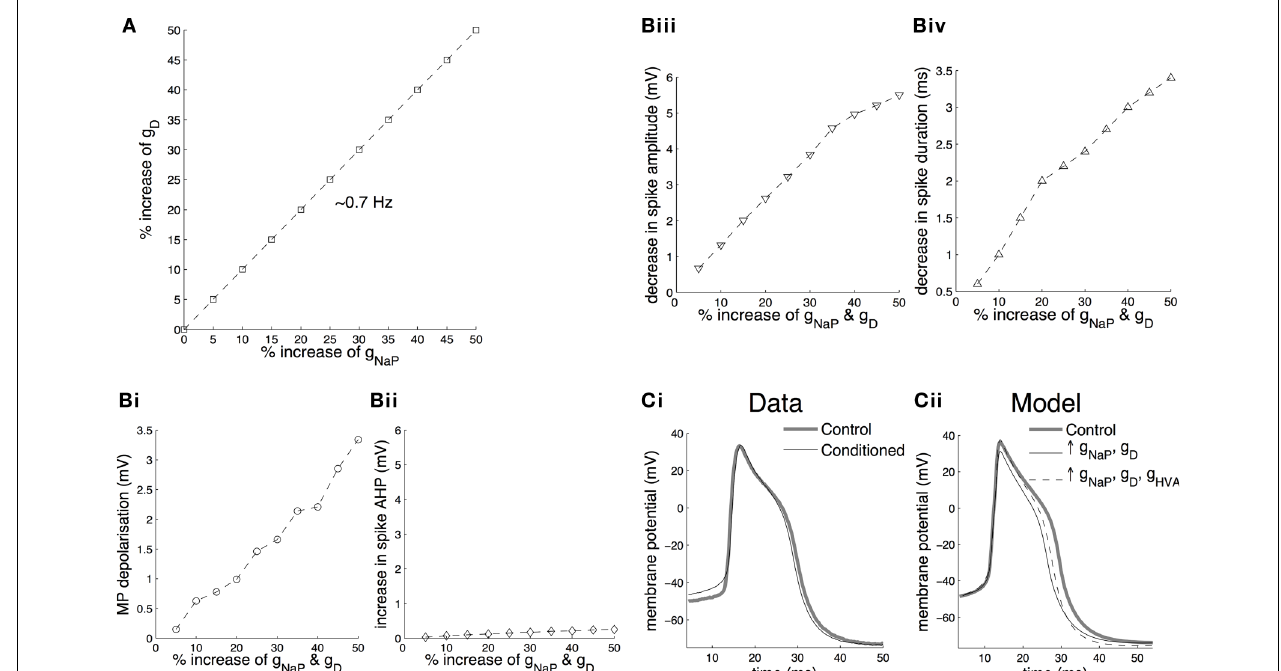
FIGURE 7 | Effects of simulating conditioning on membrane potential and depolarization by more than 2.5 mV (the experimentally observed mean spike shape in the model CGCs. (A) The effect of conditioning in the model depolarization in axotomized CGCs in isolated CNS preparations; Nikitin et al., CGCs was simulated by a balanced increase in g and g such that the 2008) (Bi) , virtually no increase in the amplitude of the spike after- NaP D spontaneous fi ring frequency before and after the increase remained hyperpolarization (Bii) , a decrease in spike amplitude by ∼ 6 mV (Biii) and a approximately the same ( ∼ 0.7 Hz). Stabilization of the fi ring frequency after decrease in spike duration by ∼ 3.5 ms (Biv) . (C) Changes in spike amplitude and increasing g between 5% and 50% of its initial value required increasing g by duration, however, do not occur after classical conditioning (example traces in Ci , NaP D approximately the same proportion. (B) A balanced increase of g and g also see Kemenes et al., 2006). These changes were fully (spike amplitude) or NaP D between 5% and 50% of their initial values resulted in a persistent membrane partially (spike duration) reversed by an appropriate increase (20%) of g